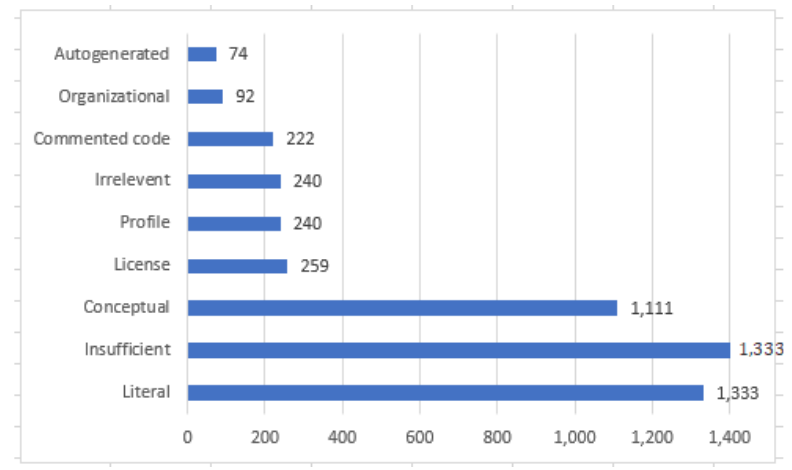
Figure 4. Distribution of code-comments data by the type column feature. Distribution of Data According to Type of Comments